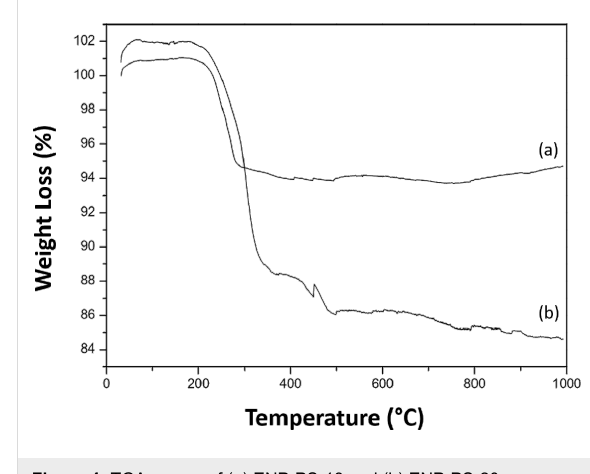
Figure 3: IR spectrum of ENP-PS-18 and those of free PS and ENPs functionalized by the ATRP initiator only (ENP-Br). described previously [15]. However, electrons pass only through 0.5 nm of the Fe-rich core after having penetrated the